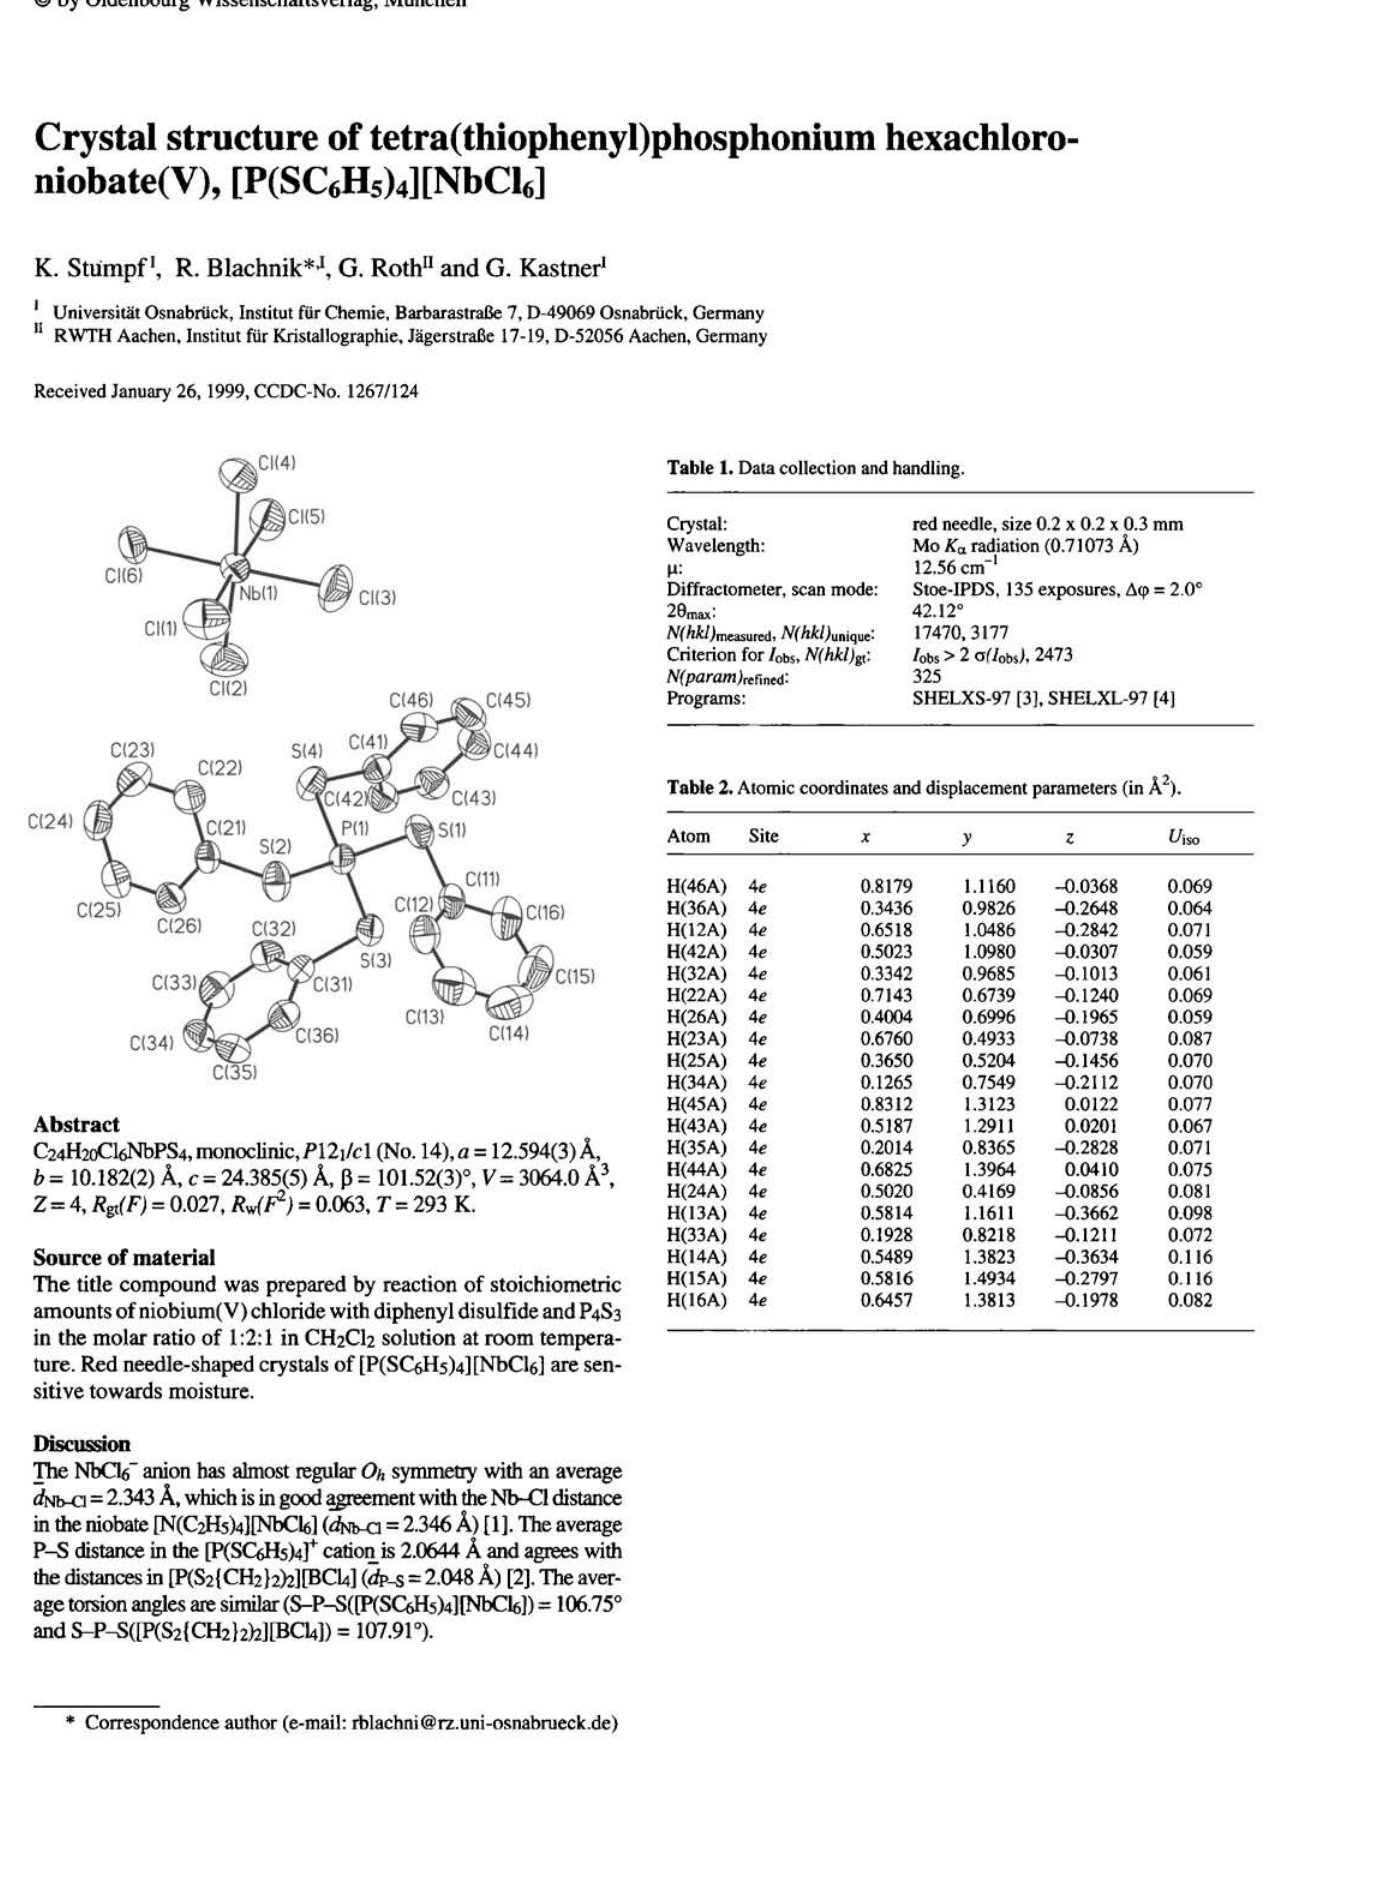
Table 2. Atomic coordinates and displacement parameters (in À 2